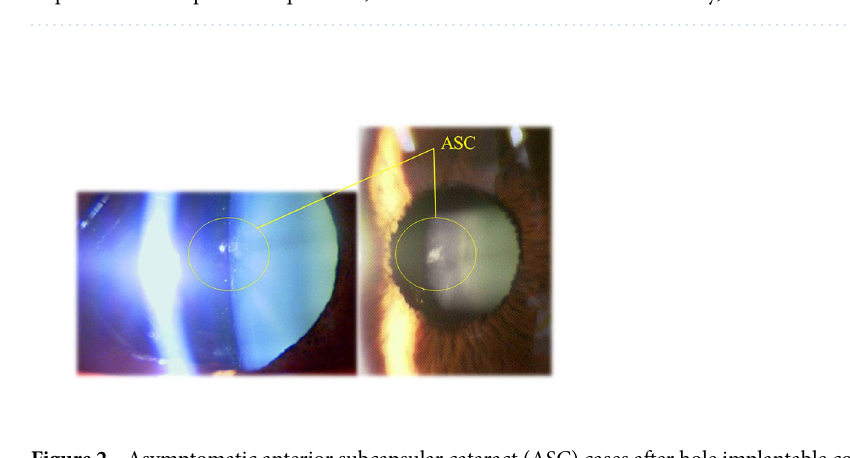
Table 2. Asymptomatic anterior subcapsular cataracts (ASC) cases after Hole implantable collamer lens (ICL) implantation. SE spherical equivalent, CDVA corrected distance visual acuity, CT corneal thickness.